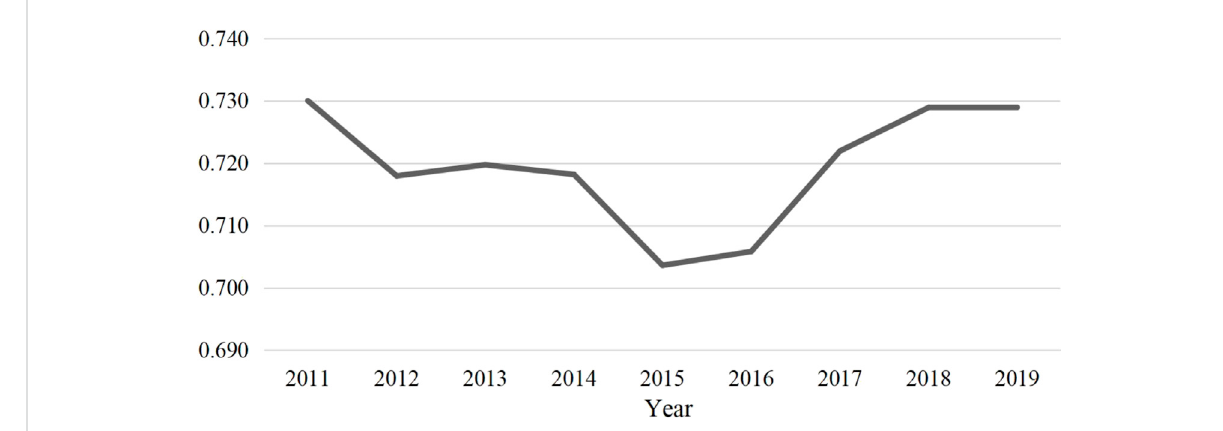
FIGURE 1 China ’ s manufacturing capcity utilization (2011 – 2019).